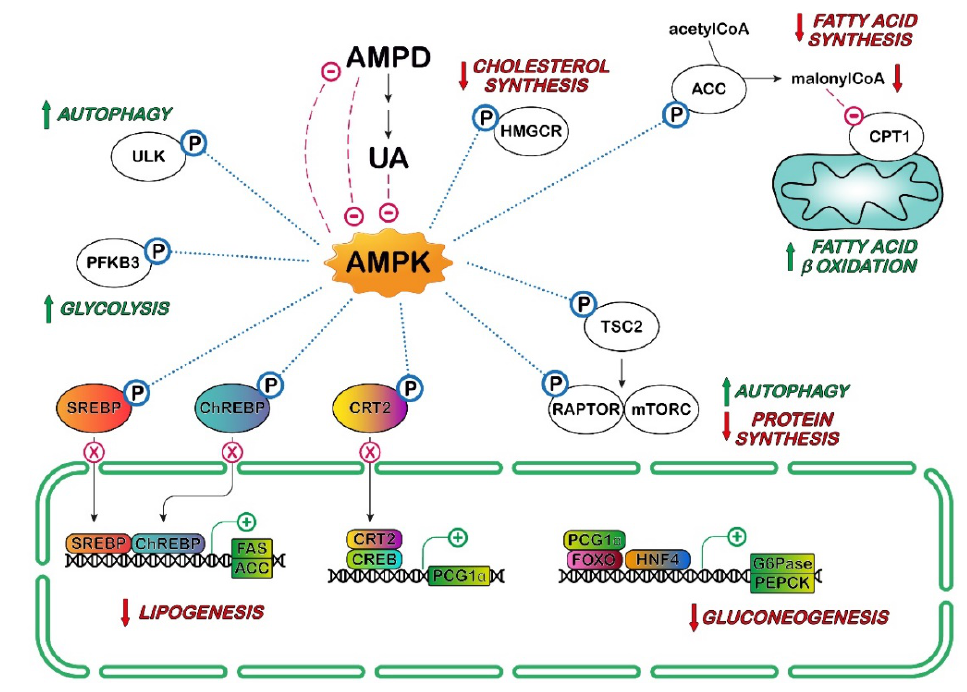
Figure 4. Effect of AMP-activated protein kinase (AMPK) on several metabolic pathways. Activation of AMPK represses anabolic processes by affecting the activities of several proteins which play cru- cial roles in protein, fatty acid, sterol, and cholesterol synthesis: target of rapamycin complex 1